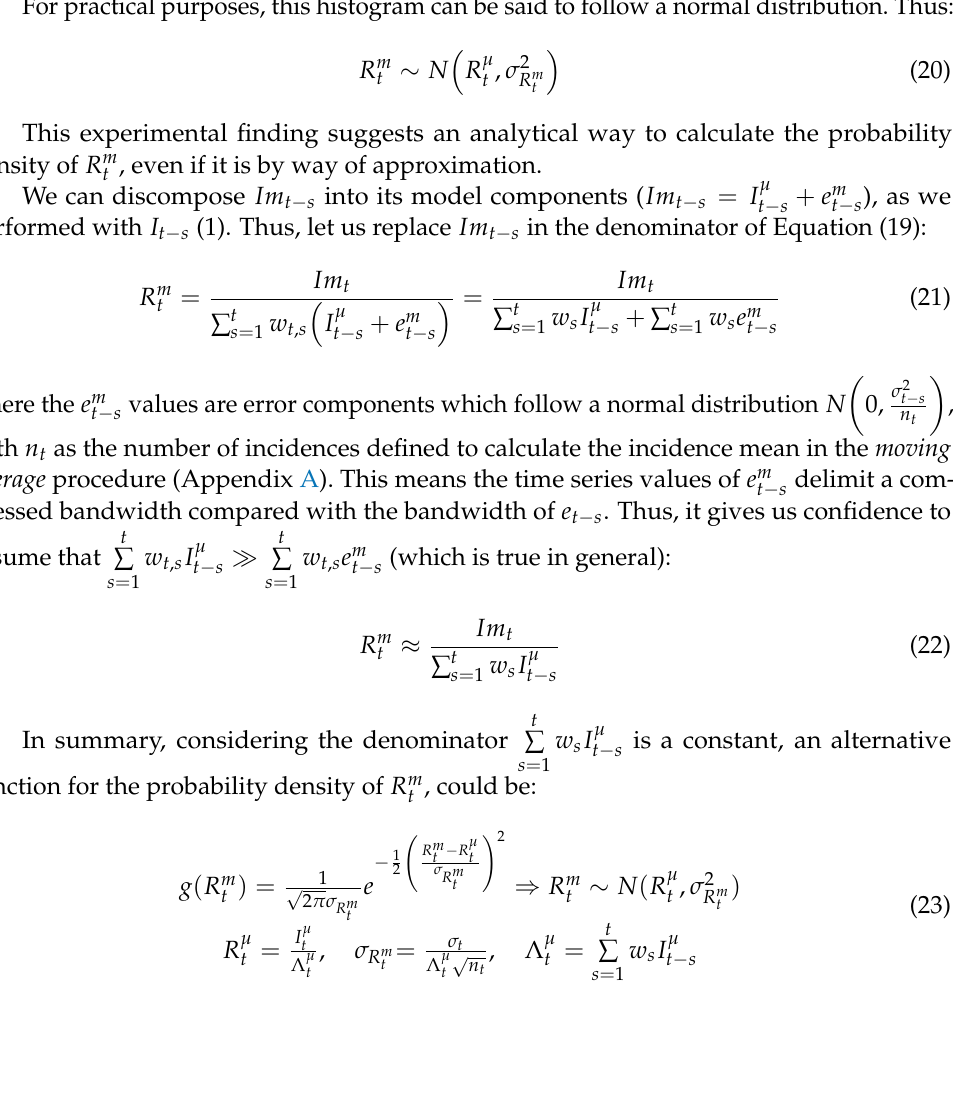
Figure 6. Histogram of the values of 320 random versions of 𝑅 (cid:3047)(cid:3040) , at time t = 100, following a Monte Carlo simulation process based on the 𝐼 (cid:3047) series data generated with the random incidence series generator.